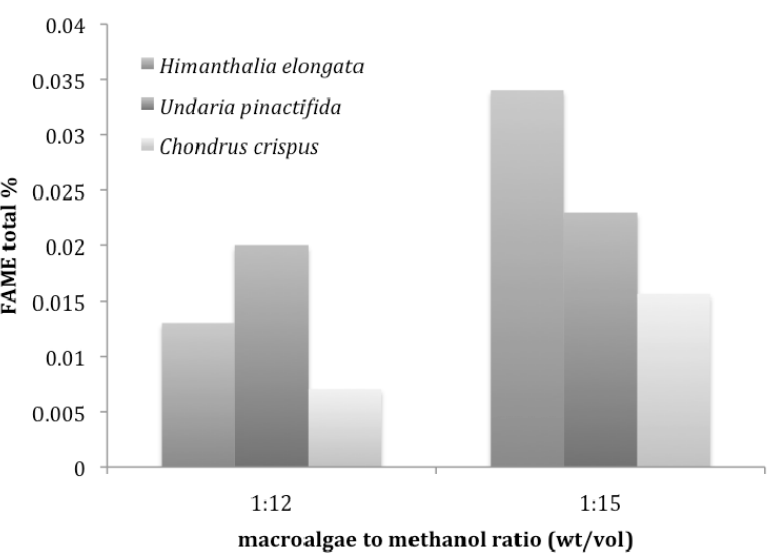
Figure 6. Effect of macroalgae to methanol ratio